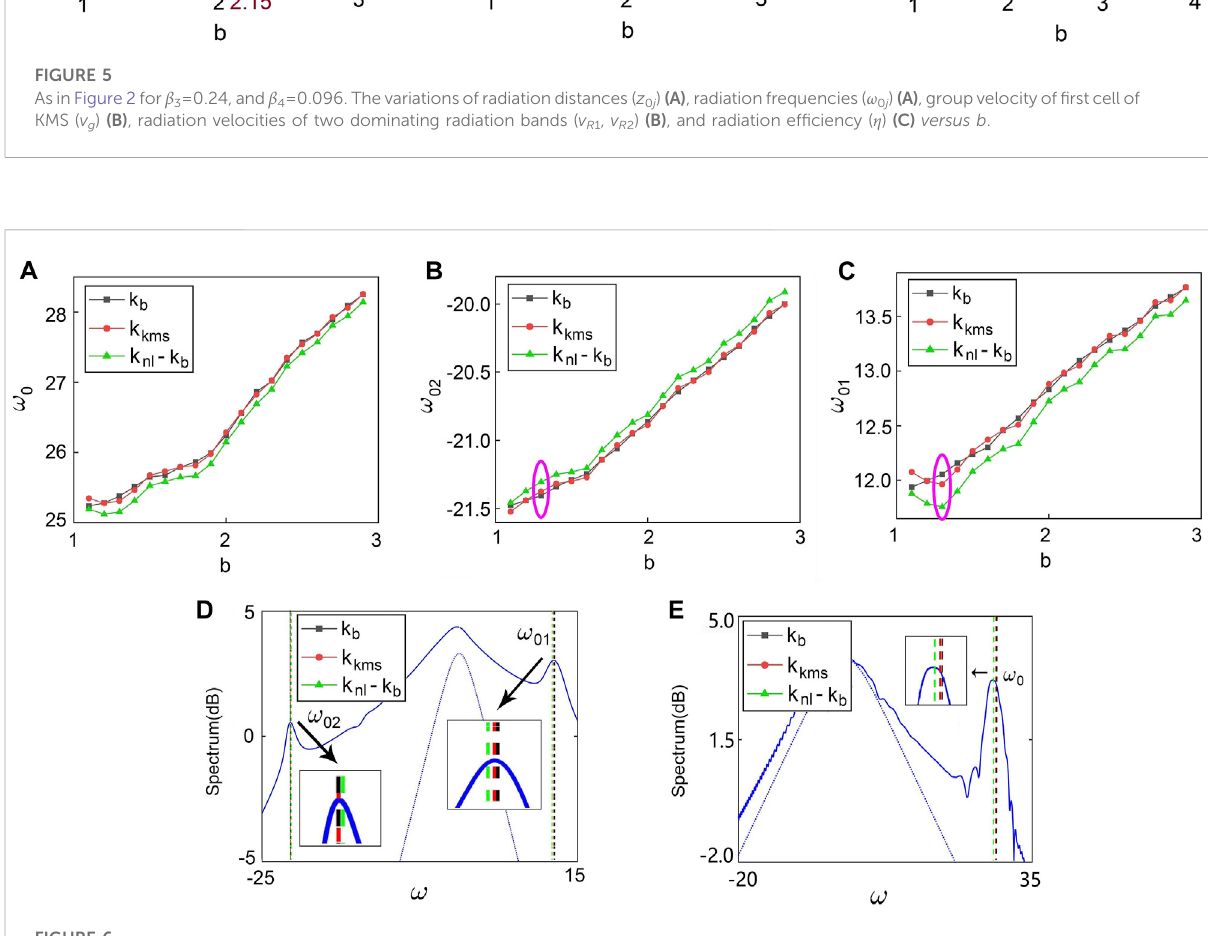
FIGURE 6 Dominant radiation frequencies under different radiation conditions [9] – [11]. (A) Variations of single radiation frequency ( ω 0 ) induced by TOD. (B,C) Variations of two radiation frequency ( ω 01 , ω 02 ) induced by TOD and FOD. (D) Comparison between radiation frequencies ( ω 01 , ω 02 ) and the numericalsimulationswithaspecial b circledin (B) and (C) . (E) Comparisonofthefrequencycalculationsforthethreeresonanceconditionswith b = 2.8 when β 3 = 0.24 and β 4 =